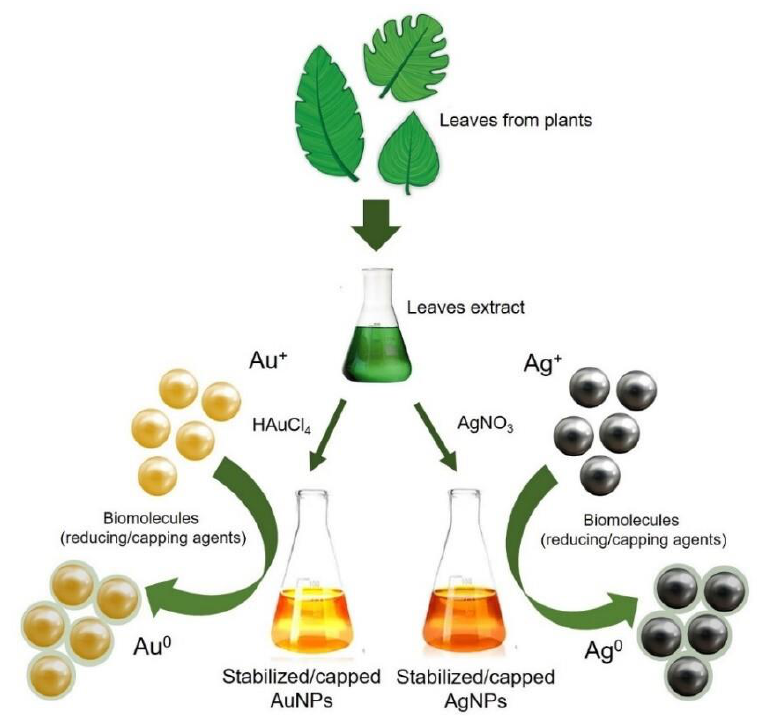
Figure 2. Schematic representation of Au NPs and Ag NPs synthesis using plant extracts.